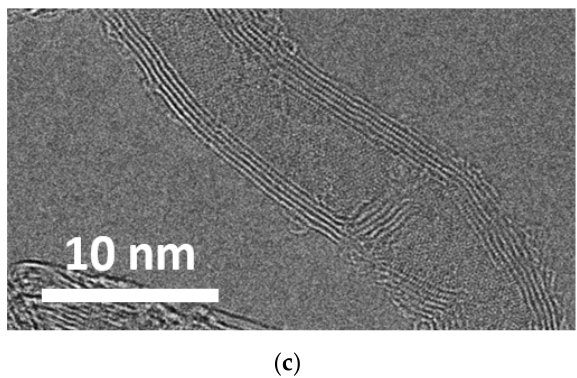
Figure 2. SEM ( a ) and TEM ( b , c ) images of CNT.